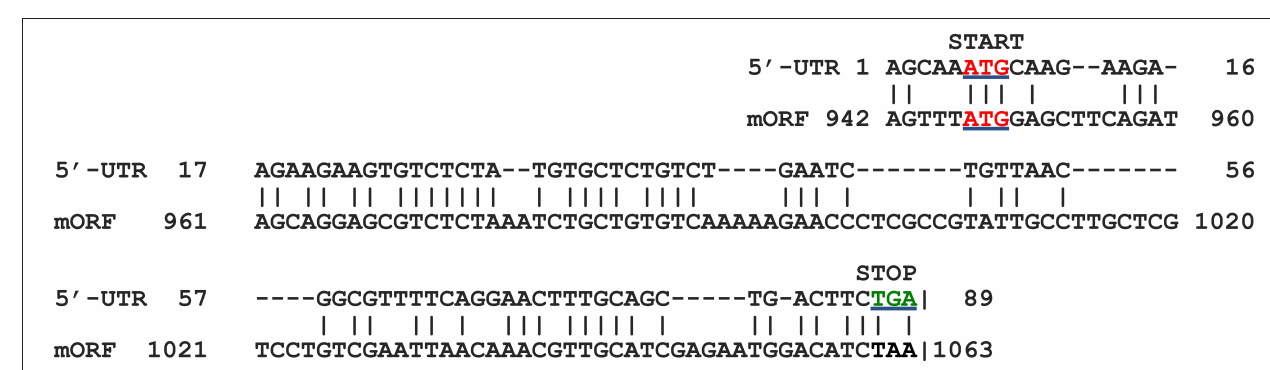
FIGURE 8 | Alignment of 5 ′ -UTR from AT2G31150 (gene 14) with its own mORF. The region of close similarity between the two sequences is shown. Start codons (ATG) are indicated in red (underlined), and stop codons (TGA) for the two ORFs in green. The region shown in the alignment shows 51% identity between the two seqences.shown. Matches are indicated by vertical lines. Amino acid sequence predicted to be encoded by 5 ′ -UTR ORF is given in Supplementary Dataset II.